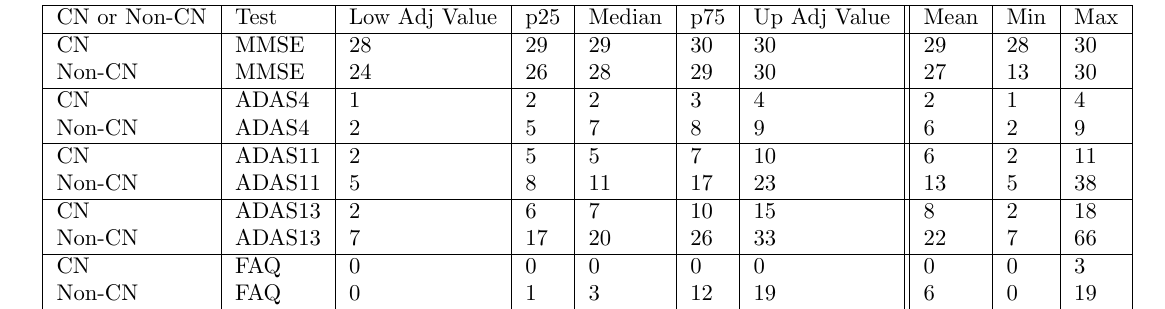
Fig. 14 Ranges of test data split by the predicted diagnosis (CN or non-CN) assigned by the diagnosis model at month 48 (with normal